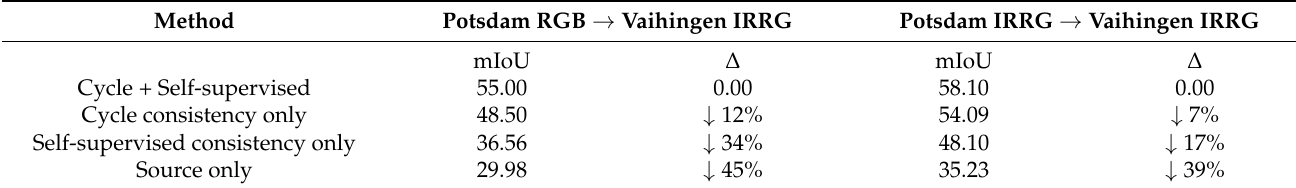
Table 3. Ablation study of effects of components of our